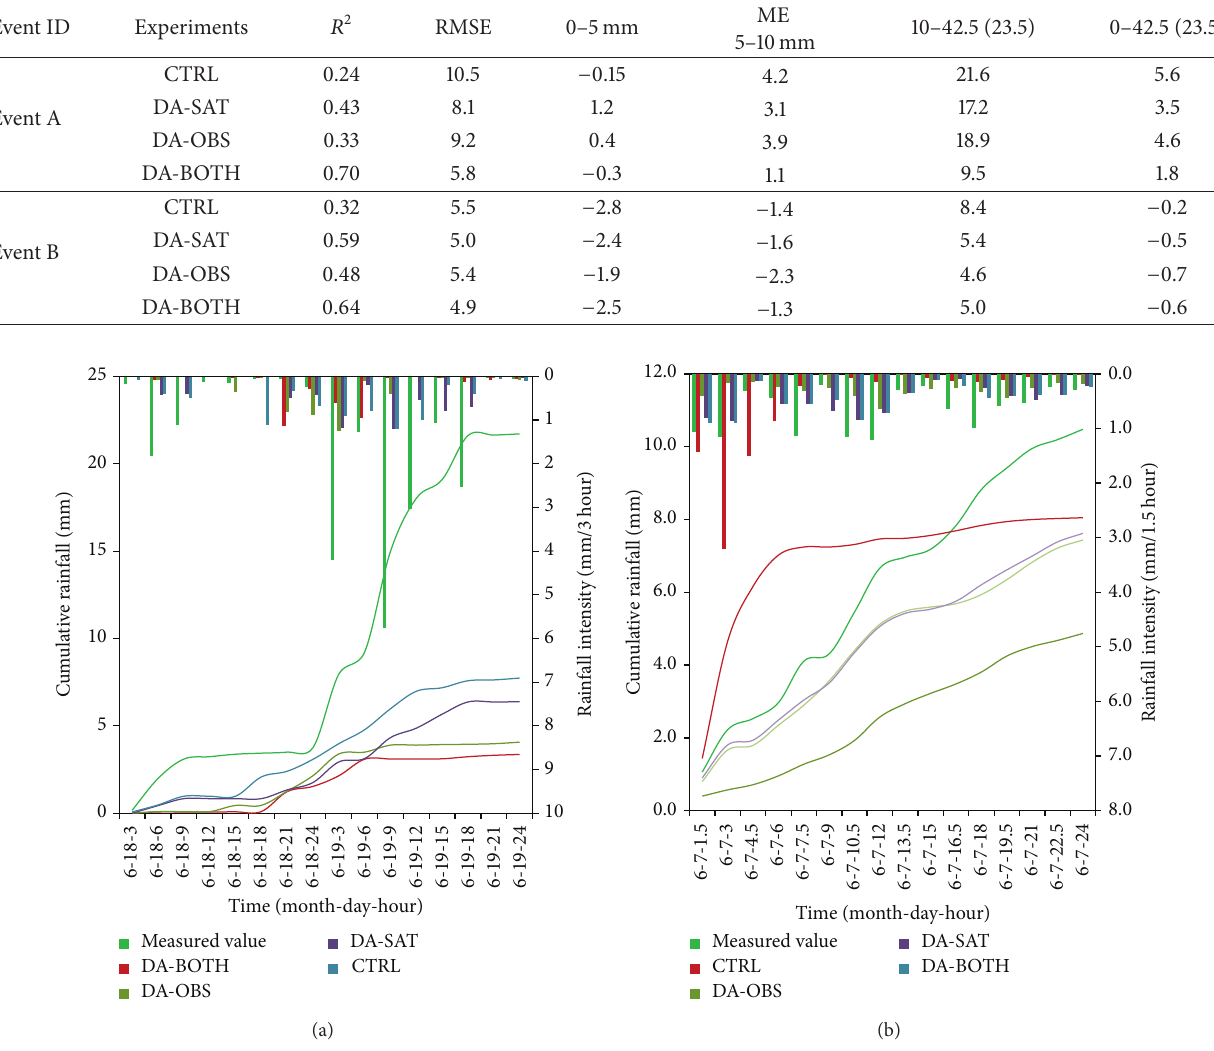
Figure 9: The rainfall intensities and cumulative curves of the values measured at the sites and the simulated results from the four numerical experiments: (a) Event A; (b) Event